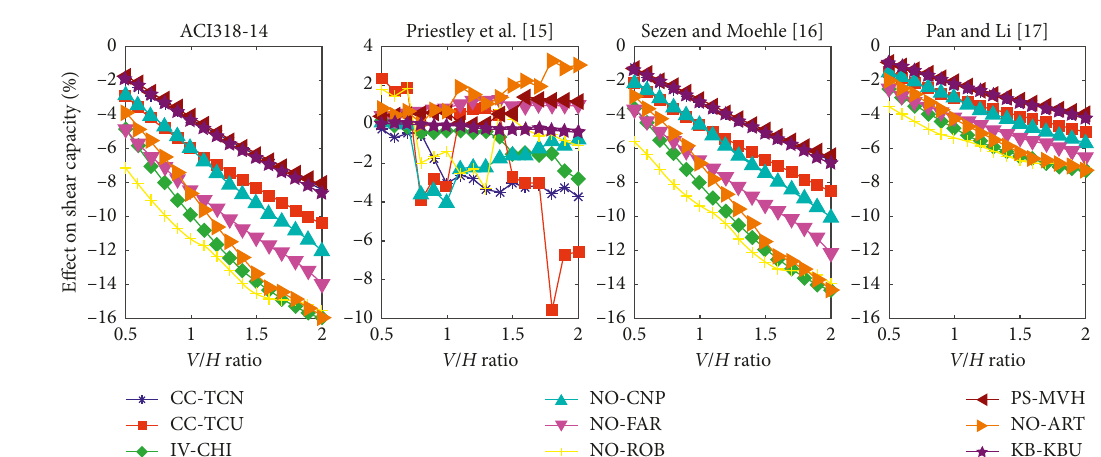
Figure 9: Effect on shear capacity by shear strength